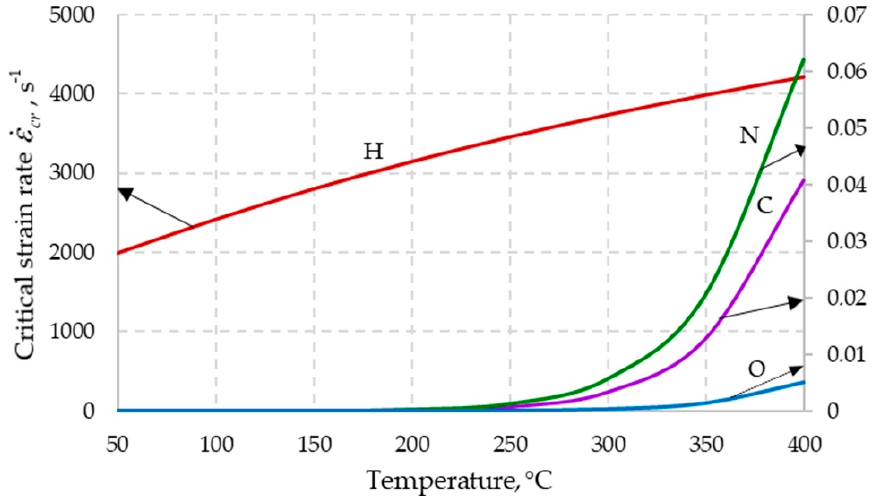
Figure 7. Dependence of the critical strain rate for impurity carbon (C), nitrogen (N), hydrogen (H) and oxygen (O) atoms on temperature at a dislocation density ρ d = 10 13 m − 2 .